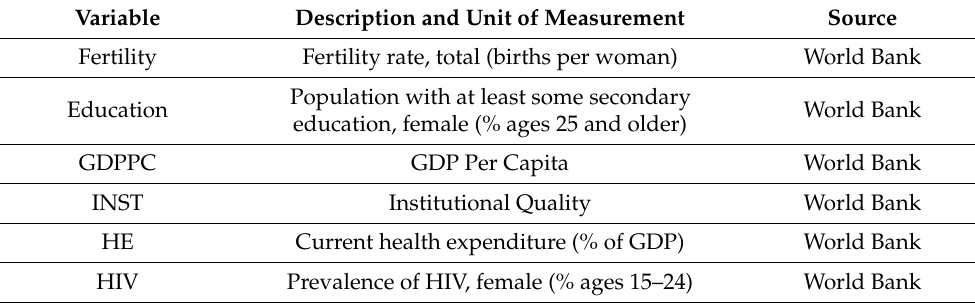
Table 1. Summary of Variable